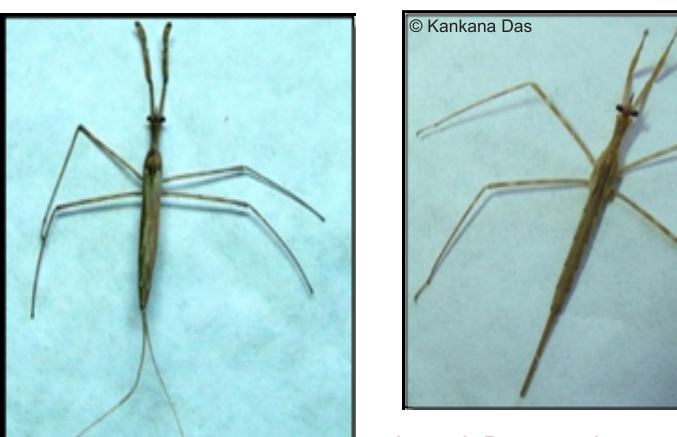
Image 6. Ranatra